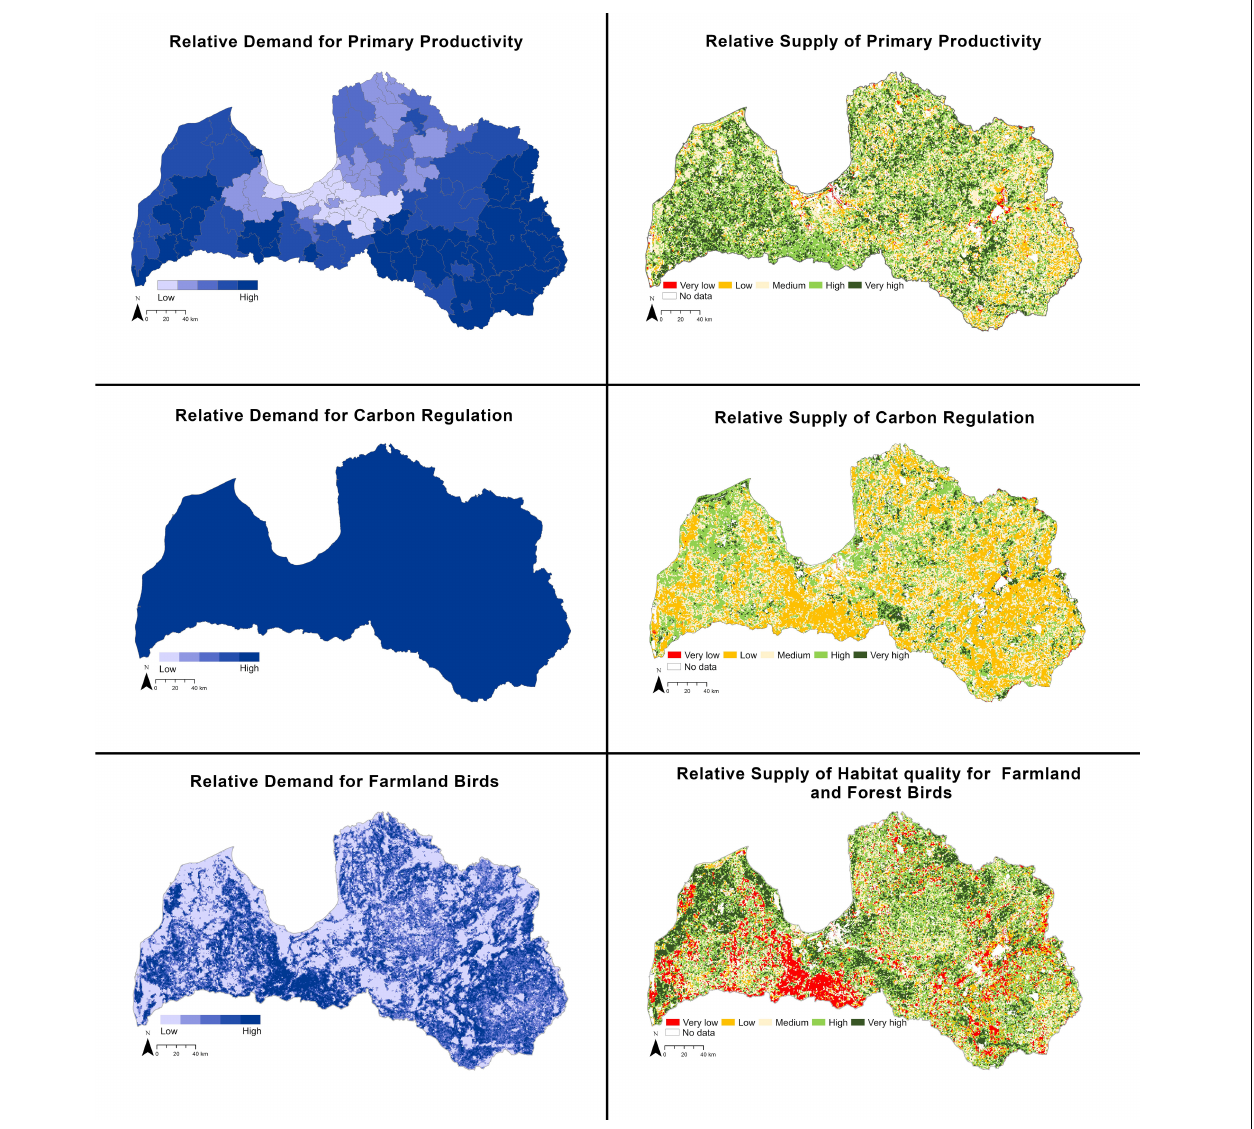
FIGURE 8 | Indicative maps of the normalized demand (left column) and supply (right column) for the three soil functions, from top to down: primary productivity, carbon regulation and biodiversity.